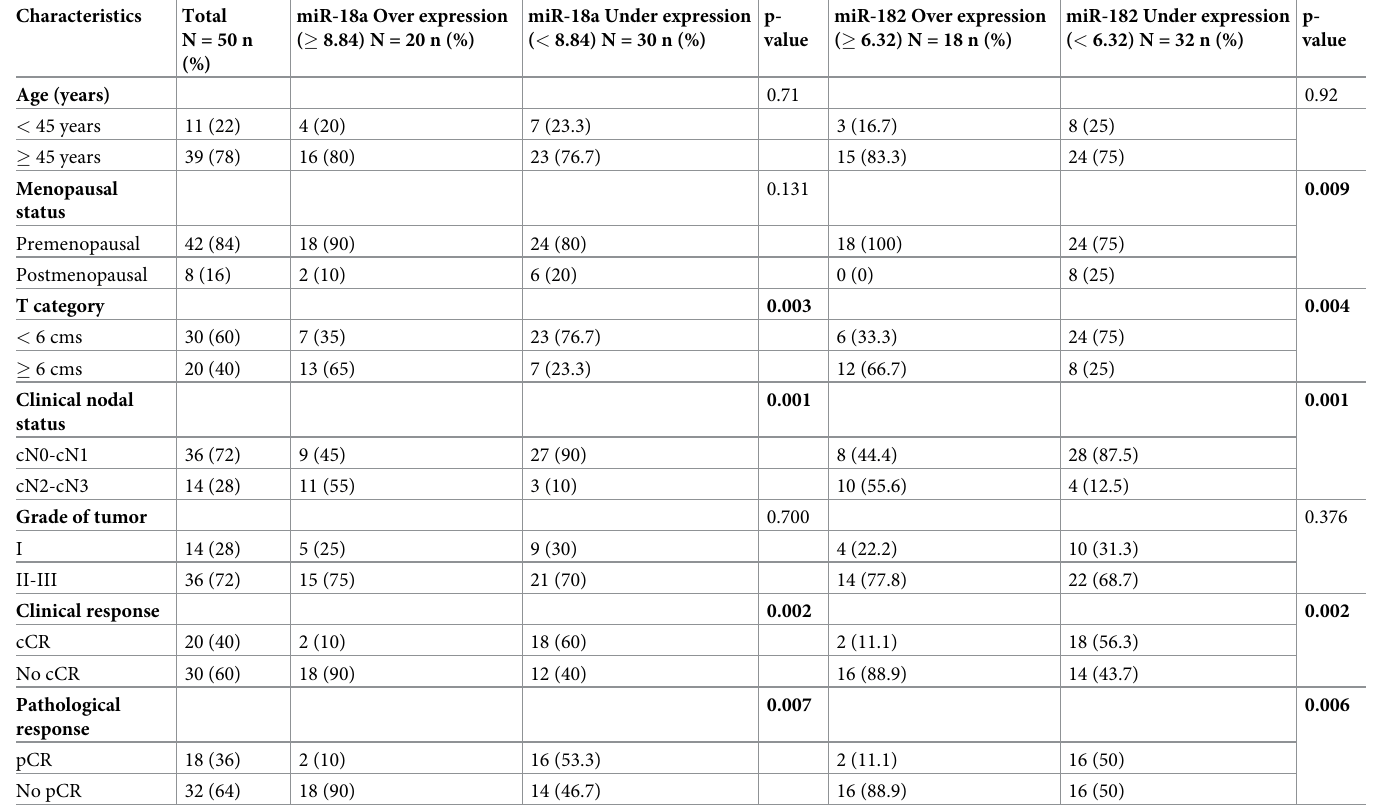
Table 3. Correlation of the tumor profile and survival with the miR expression.